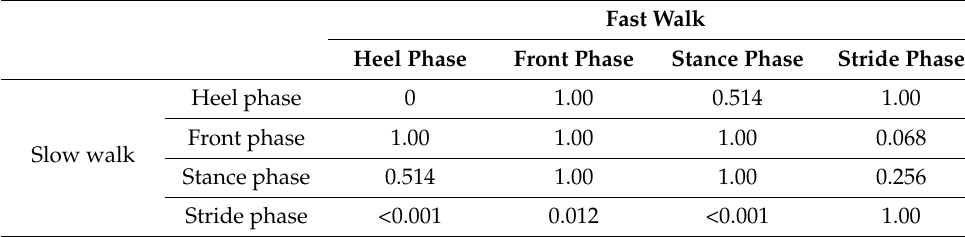
Table A6. Significance level of post hoc tests, comparing run and slow